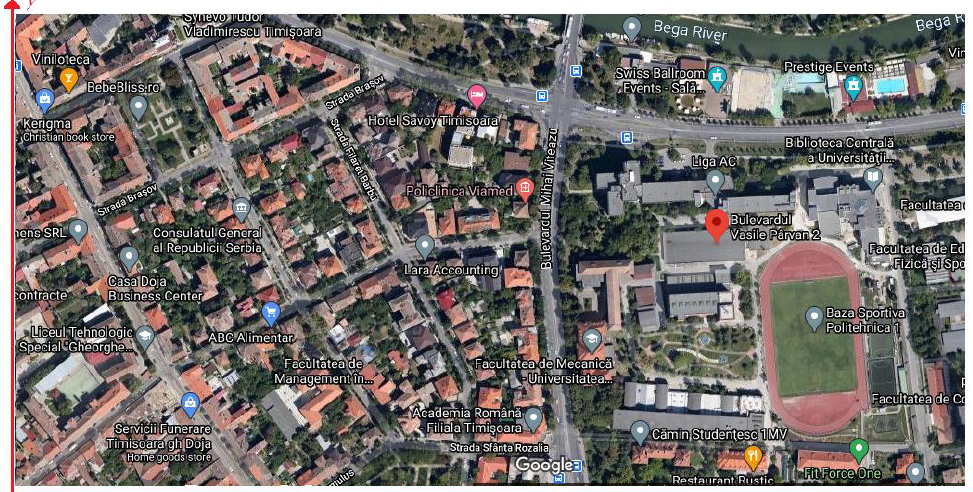
Figure 2. Roads in the neighborhood near our faculty building [5,6].